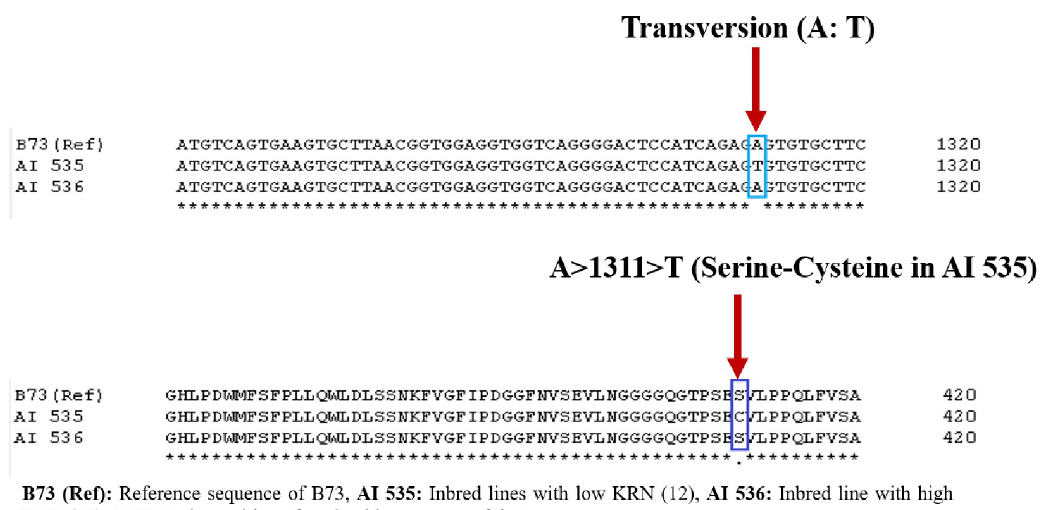
Fig 2. (a) Comparative nucleotide sequence of test and reference genotypes showing transversion (A: T) at 1311bp of fea2 gene, (b) Comparative amino acid sequence of test and reference genotypes showing conversion of cysteine/serine due to A: T